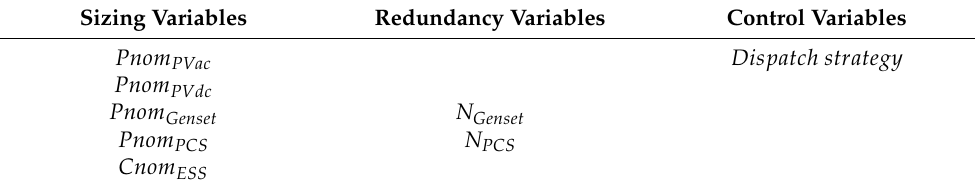
Table 1. Sizing variables of the genetic